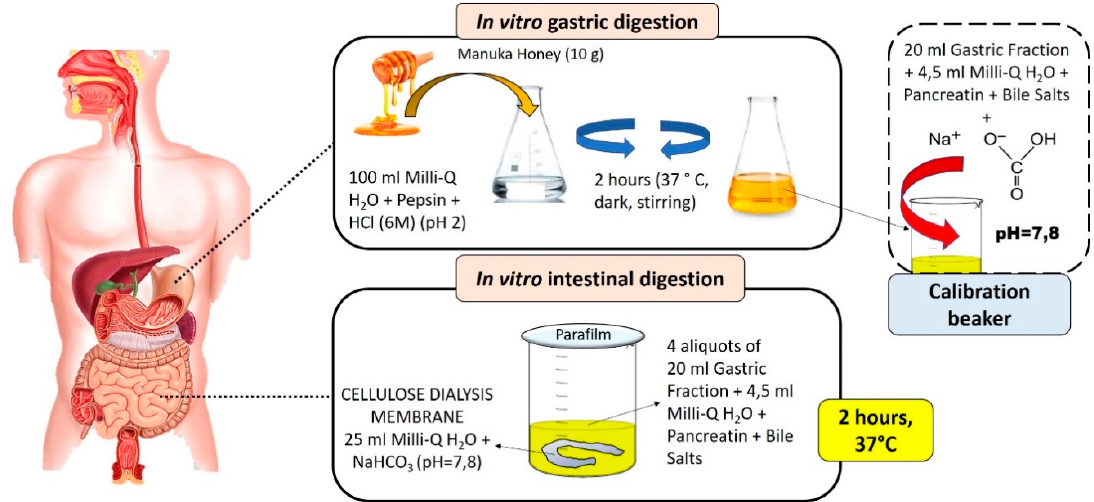
Figure 1. Graphical and schematic representation of the in vitro gastrointestinal digestion process.